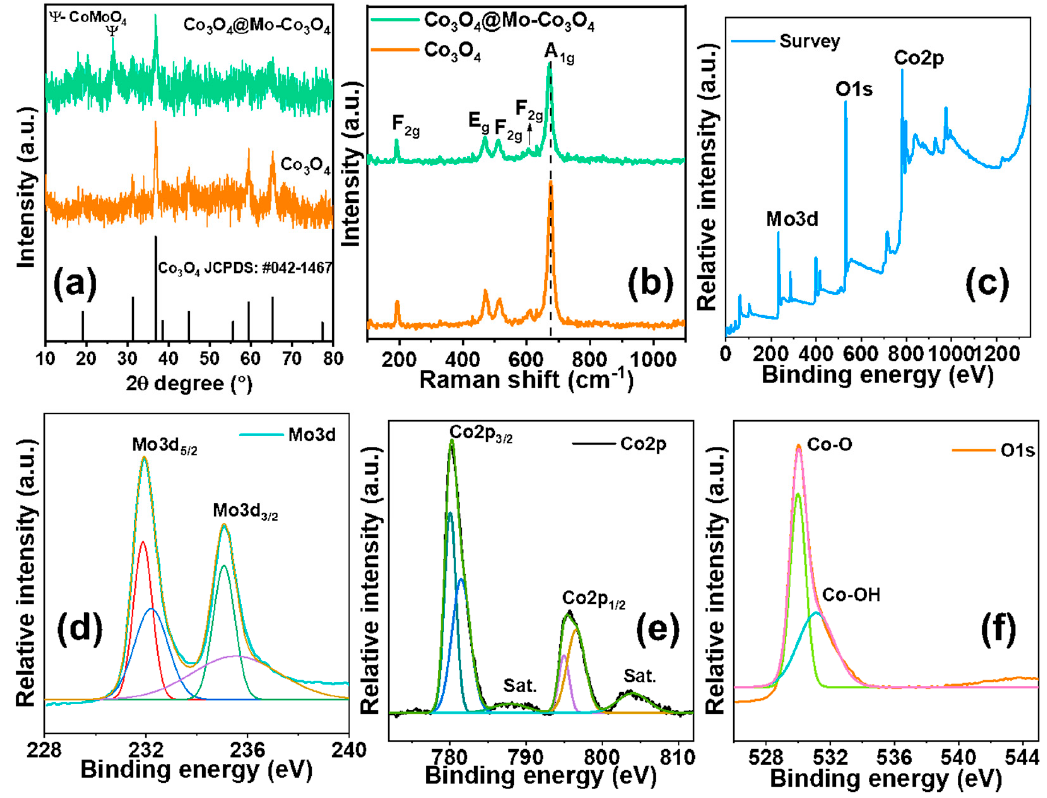
Figure 2. ( a , b ) XRD pattern and Raman spectra of Co 3 O 4 and Co 3 O 4 @Mo-Co 3 O 4 needle-like